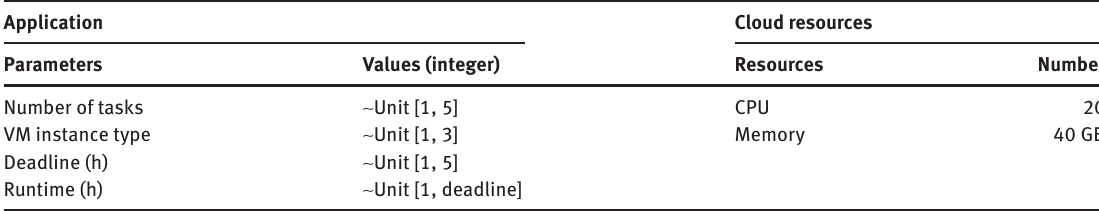
Table 10: Parameters of Problem Instance 1.